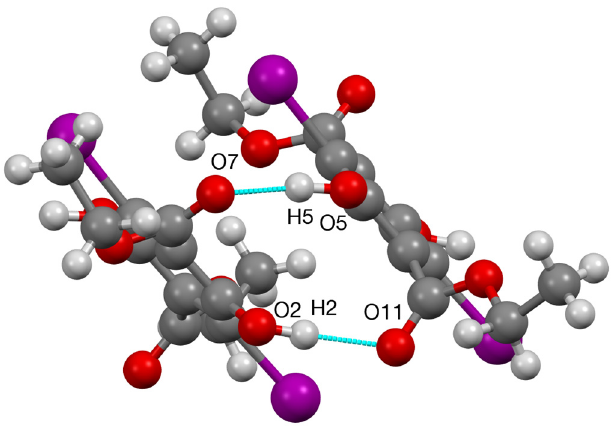
Figure 2. The basic hydrogen bonding pattern. Table 1. Hydrogen bonding parameters for 1 (Å, °).